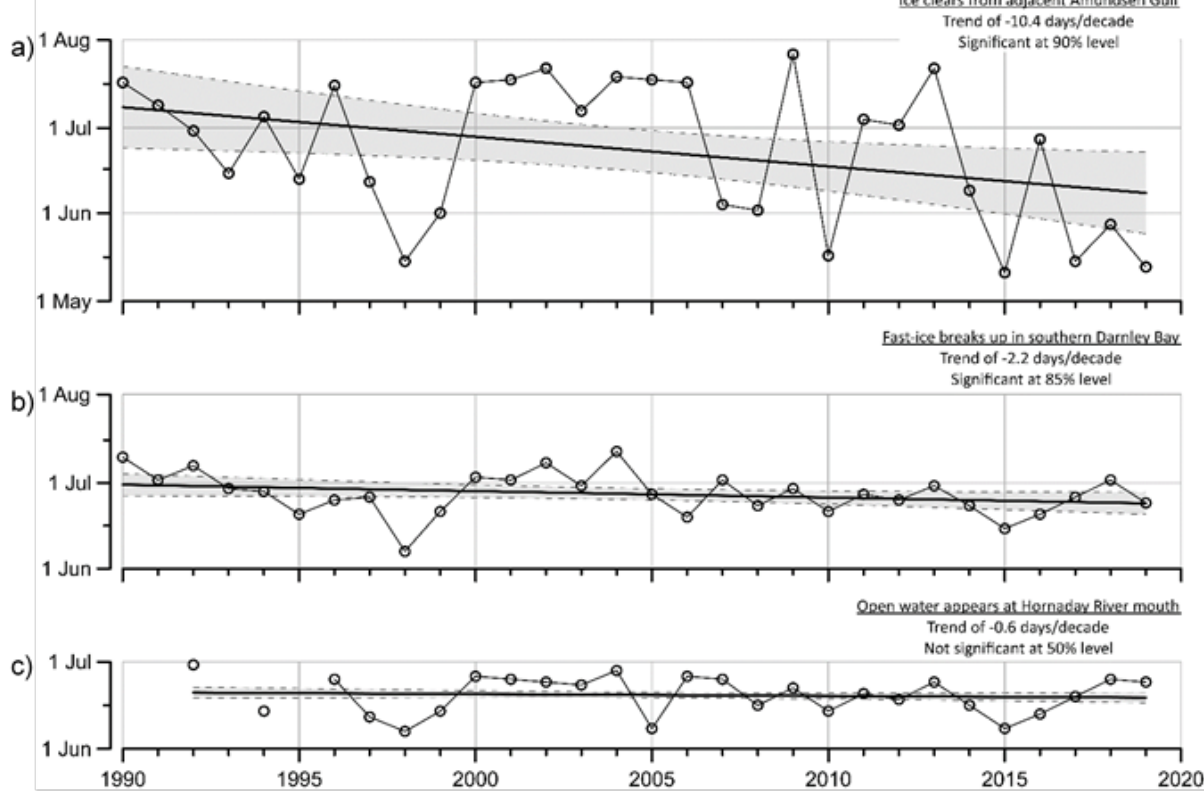
Figure 9. Timing of ice break-up from 1990 to 2019 in a) Amundsen Gulf, b) southern Darnley Bay, and c) mouth of the Hornaday River. Figure provided by H.